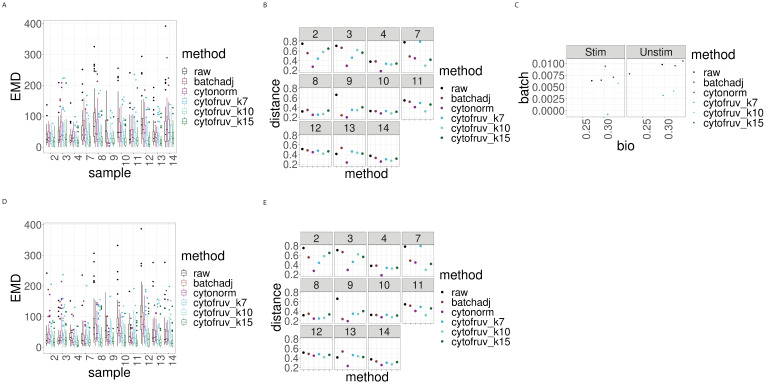
Metrics to assess the effectiveness of the normalisation methods on the BatchAdjust dataset.In all panels, the colour indicates either the raw data or the method used for normalisation. (A) Boxplots of the Earth Movers Distance (EMD) between paired protein expression distributions for each batch’s stimulated sample compared to that in the first batch. (B) Hellinger distances between paired cell subpopulation proportions for each batch’s stimulated sample compared to that in the first batch. (C) Mean Silhouette scores computed for all stimulated and unstimulated samples with those for cell subpopulations (bio) on the x-axis and for batch (batch) on the y-axis. (D) Same as (A) for the unstimulated samples. (E) Same as (B) for the unstimulated samples.